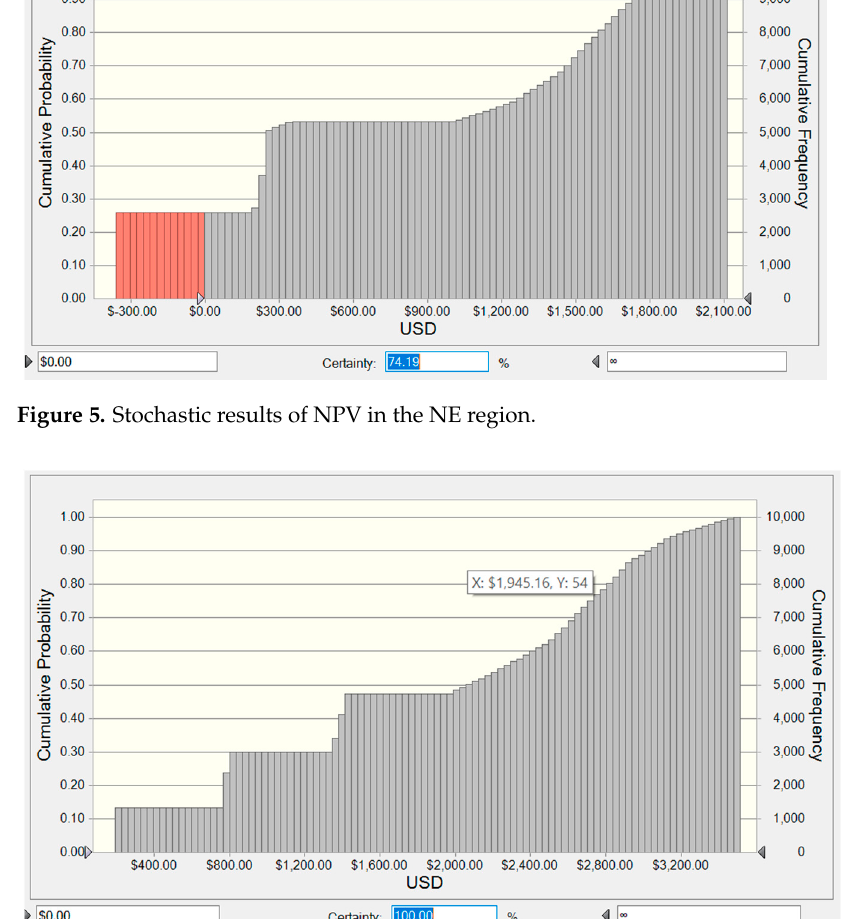
Figure 6. Stochastic results of NPV in the CW region.